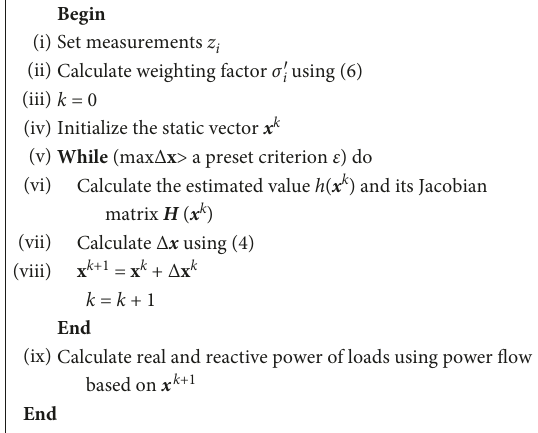
Figure 13: Pseudocode algorithm for the state estimation.